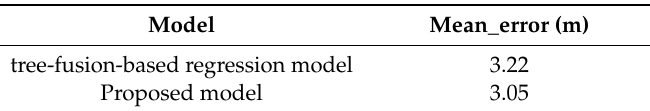
tree-fusion-based regression model.